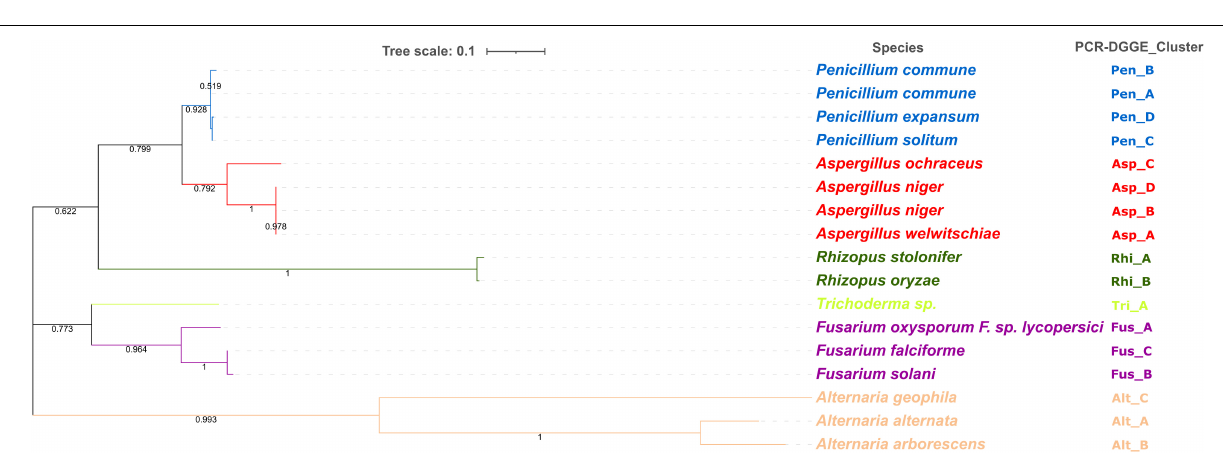
FIGURE 5 | Alluvial plot showing the frequency of fungi genus grouped in six PCR-DGGE clusters and isolated from dried hazelnuts belonging to eight cultivars cultivated and processed in 10 geographical areas.